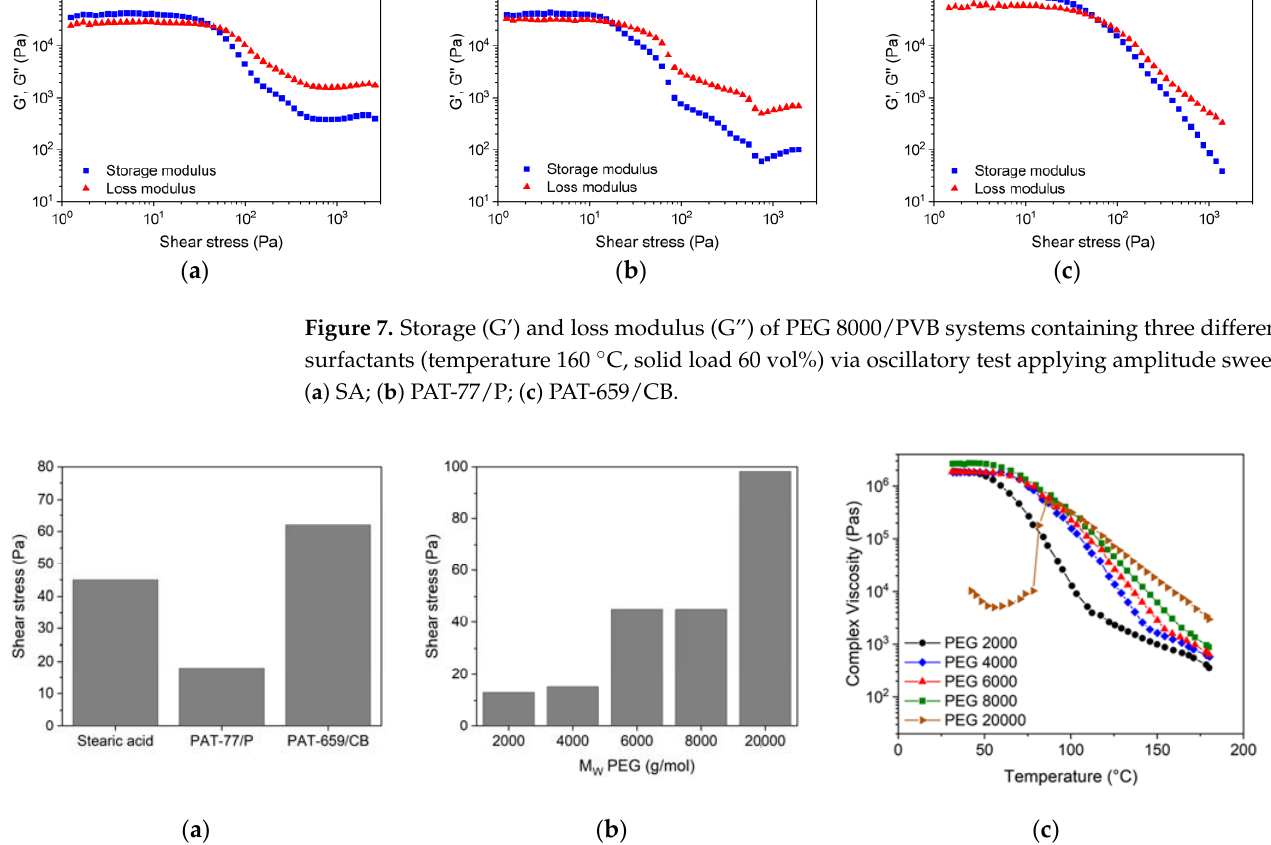
Figure 8. Yield points for PEG/PVB feedstocks (160 °C, solid load 60 vol%). ( a ) Applying PEG 8000 and different surfactants; ( b ) applying PEGs with different M W and SA as surfactant; ( c ) complex viscosity as function of temperature and PEG with different M W and SA as surfactant.